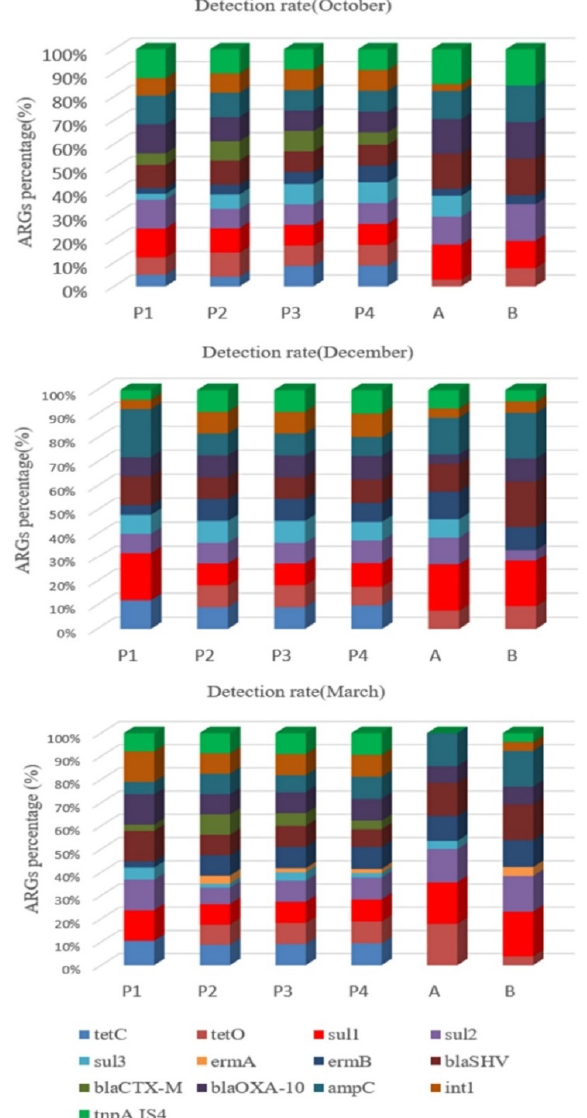
Figure 1. Detection rate of resistance genes in samples collected in different months. As can be seen from Figure 1, the frequency of detection of these genes varied greatly. For samples collected in October, the sulfonamide resistance genes sul1 , the β -lactam resistance genes blaOXA-10 and ampC , and transposon tnpA-IS4 had the highest detection rates in water samples, and β -lactam resistance genes blaSHV , blaOXA-10 and transposon tnpA-IS4 had the highest detection rates in soil samples. The detection rate of sulfonamides resistance gene sul1 was highest in both water and soil samples collected in